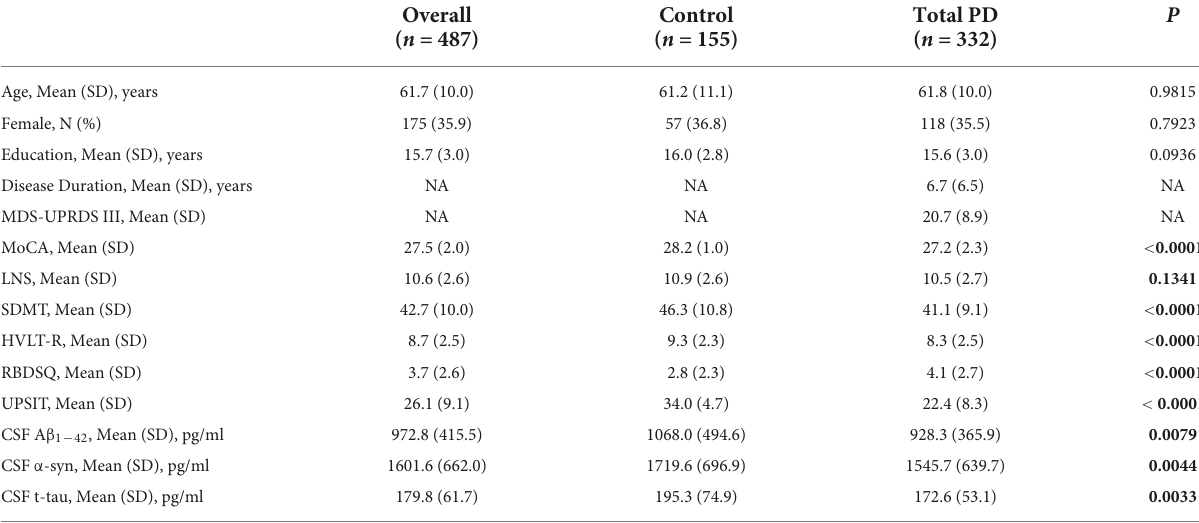
TABLE 1 Baseline characteristics of included participants.